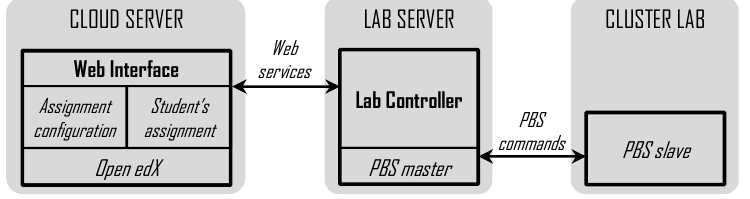
Fig. 1. General platform